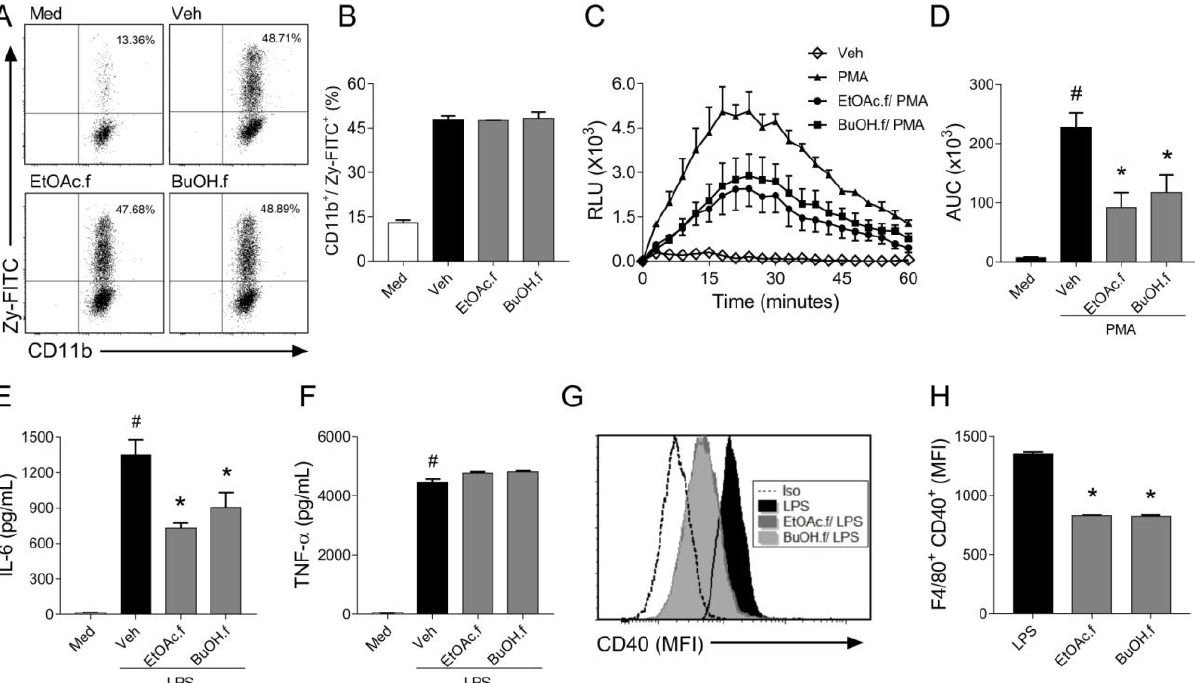
Figure 3. EtOAc.f and BuOH.f modulate inflammatory responses of BMDMs. BMDMs were pretreated (30 min) with 10 µg/mL of EtOAc.f or BuOH.f and inflammatory responses were evaluated. ( A , B ) BMDMs were incubated with FITC-labeled zymosan (100 µg/mL) and stained with CD11b. Phagocytic activity was assessed using a flow cytometer analyzing frequencies of CD11b + /Zy-FITC + cells. ( A ) Representative dot plot from cell acquisition in a flow cytometer; ( B ) quantification of percentages of cells CD11b + /Zy-FITC + . ( C , D ) BMDMs were stimulated with PMA (100 ng/mL) and ROS production was monitored. ( C ) Curves of ROS production over time and ( D ) quantification of the area under the curve (AUC). ( E ) IL-6 and ( F ) TNF- α levels were determined in supernatant of culture of BMDMs stimulated with LPS (1 µg/mL) for 24 h ( G , H ). Analysis of CD40 expression on the surface of BMDMs stimulated with LPS. ( G ) Representative flow cytometry-based analysis showing Median Fluorescence Intensity (MFI) and ( H ) quantification of MFI as the expression of CD40 on F4/80 + macrophages. Data represent mean ± S.E.M. of triplicates of one representative experiment. # and * indicate a statistically significant difference comparing to Veh group or Zym group, respectively, p < 0.05.